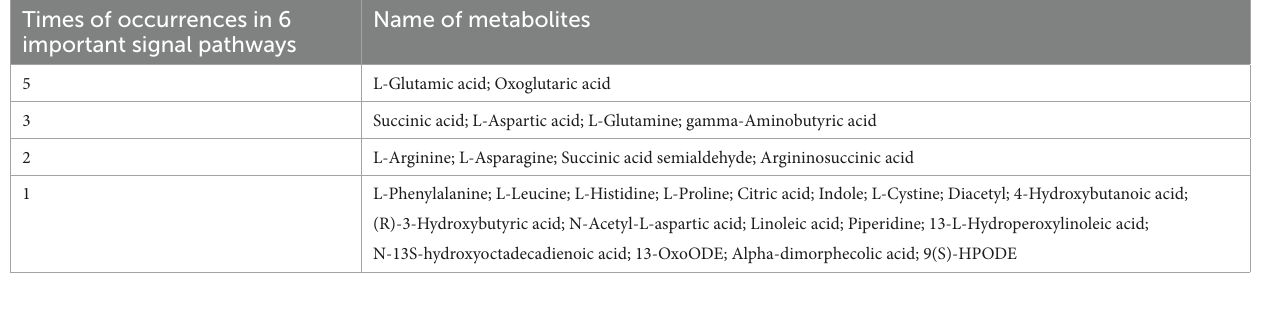
TABLE 3 Times of occurrences in the six important signal pathways.